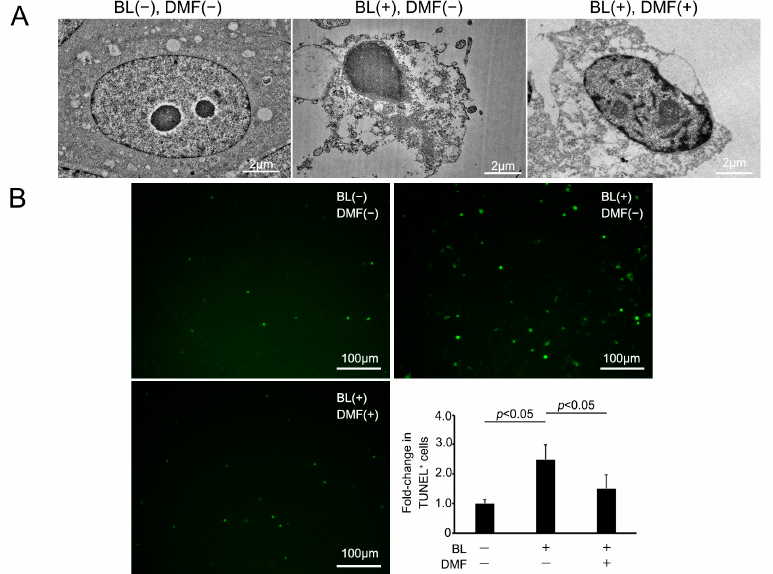
Figure 3. Apoptotic change of ARPE-19 cells after blue-light (BL) exposure and with DMF. (A) Following BL exposure, ARPE-19 cells without DMF display numerous vacuoles in the cytoplasm, indicating apoptotic changes. By contrast, those also with DMF only have minor changes. (B) TUNEL, an apoptotic cell marker, staining of ARPE-19 cells revealed a significantly greater number of TUNEL-positive cells after 24 h exposure, which was alleviated by DMF ( n = 7 for BL exposure without DMF treatment and with DMF treatment, n = 5 for neither BL exposure nor DMF treatment). Statistical analysis was performed using one-way ANOVA, followed by Tukey’s multiple comparisons test where appropriate. DMF = dimethyl fumarate.